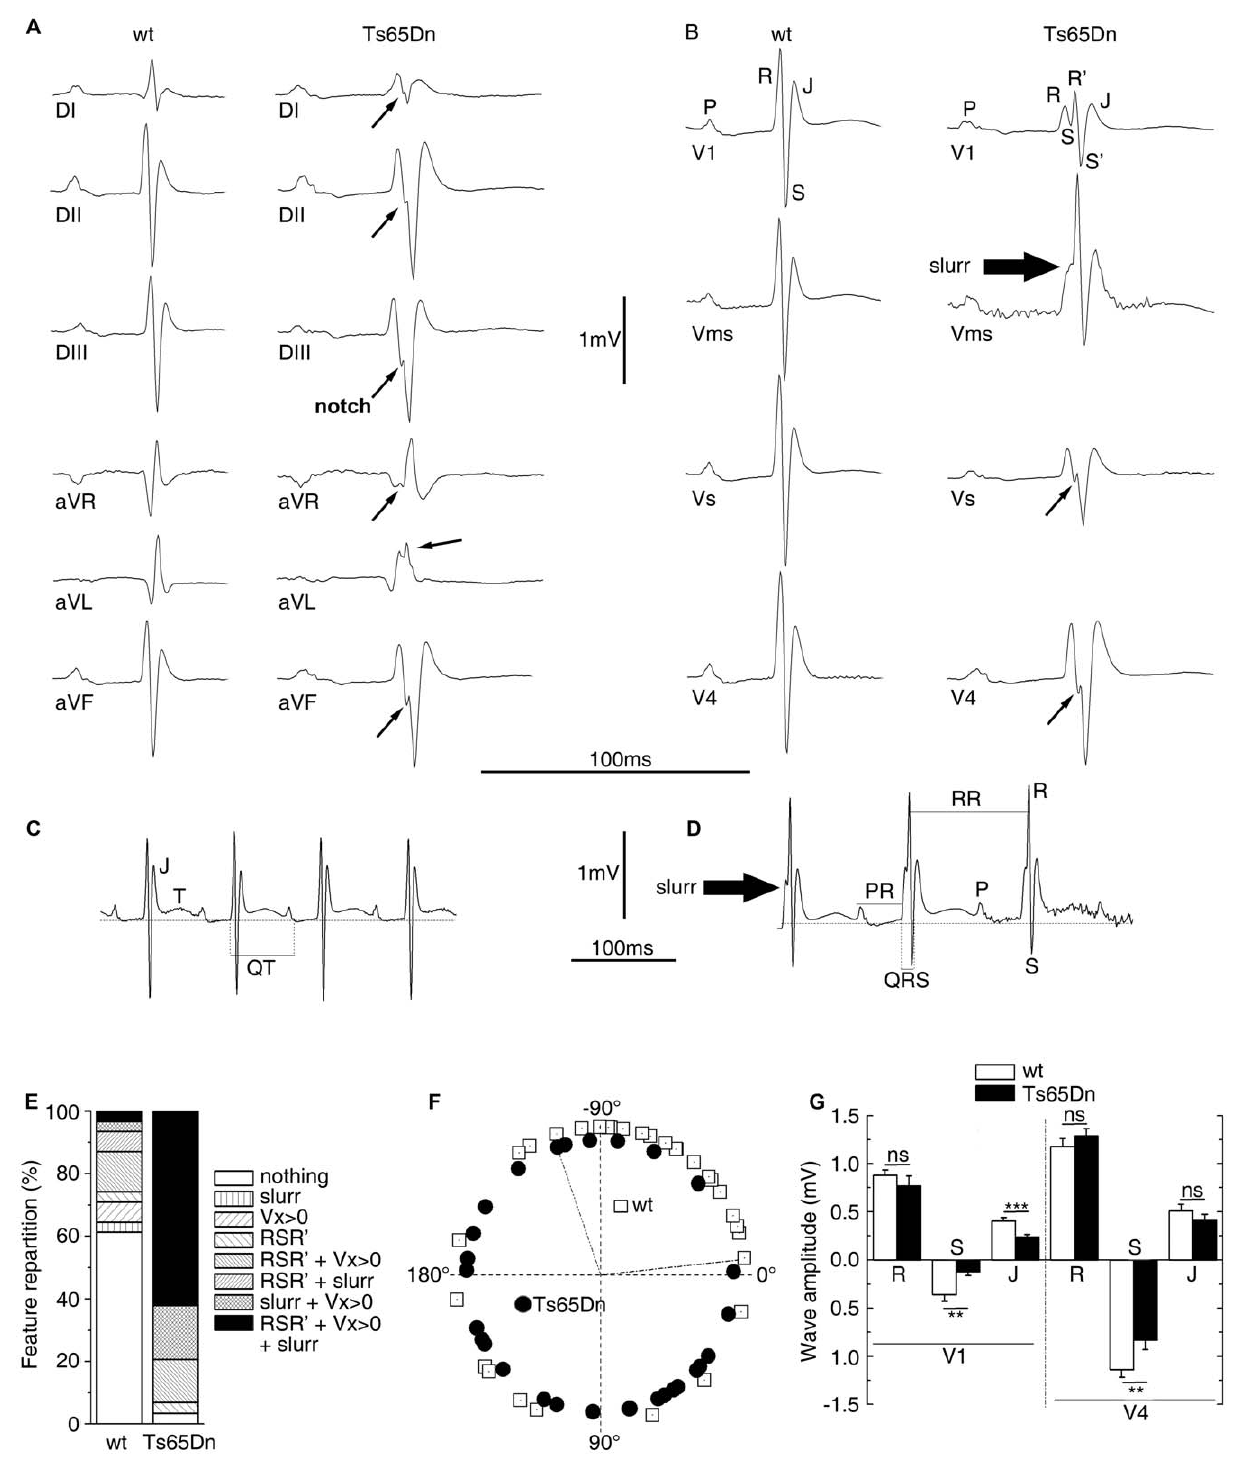
Figure 2. ECG analyses of urethane anaesthetized Ts65Dn adult mice revealed cardiac conduction anomalies. Peripheral (A) and precordial (B) leads are presented for the wt and the Ts65Dn mice in the left and right columns respectively. Wt ECG showed a smooth tracing in all leads. P wave, QRS complex and J wave are clearly distinguishable. Ts65Dn ECG showed notching of the S wave in most leads. In V1, QRS amplitude was reduced with a fragmented RSR’S’ complex. A slurr was found in the Vms lead. Notice the prolonged PR interval. Representation of Vms lead from wt (C) and Ts65Dn (D) showed measurements performed on wave amplitudes and durations. The isoelectric line (zero) was taken as the mean potential just preceding the R wave and J and T waves were labeled. The T wave was always positive in this lead while it could be elusive in other leads. ECG features (E) were classified according to the presence of fragmented QRS (RSR’S’), slurr and S wave absence (Vx . 0) in the precordial leads. 62% of the Ts65Dn mice showed 3 anomalies while 61% of the wt was free of such features. Frontal QRS electrical axis distribution (F) was evenly distributed in Ts65Dn while that of wt animals showed a leftward preferential orientation. Measurement of wave amplitudes in precordial leads (G)